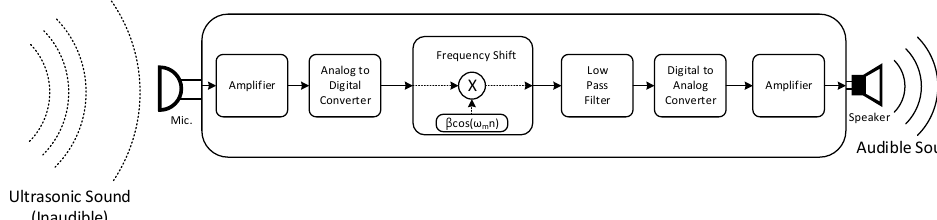
Figure 6. Simplified schematic block diagram of the receiver.